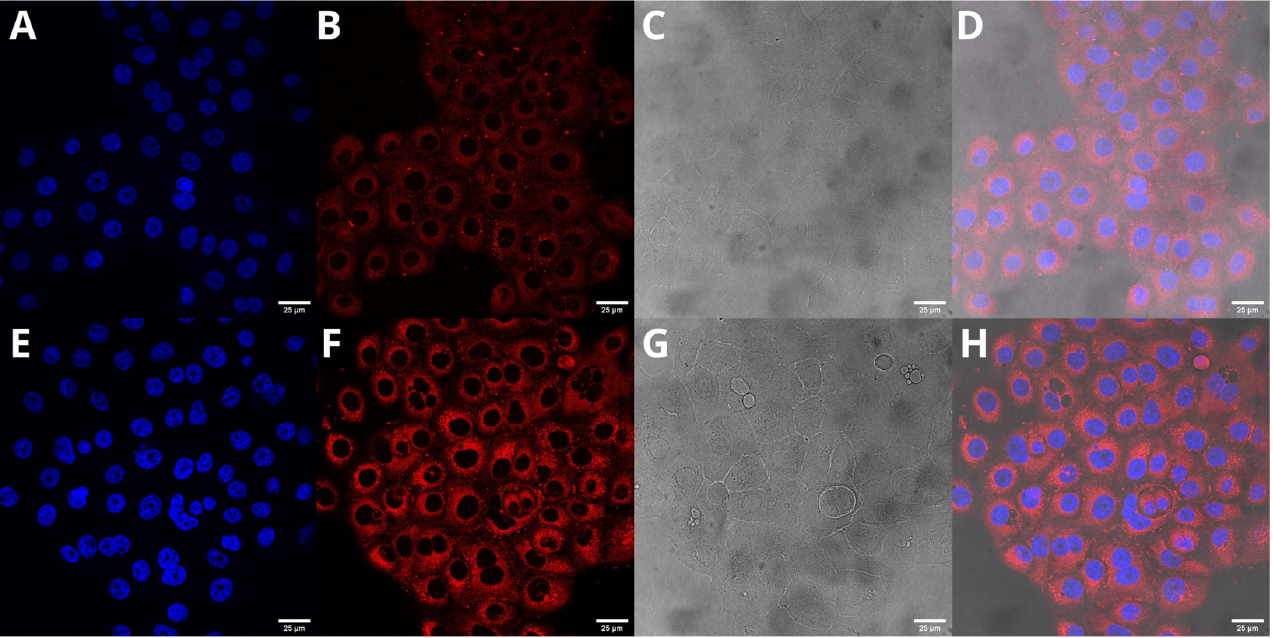
Figure 15. Visualization of the cellular uptake of Nile-Red-loaded UA-S85-PLGA-PEG2000 nanoparticles by BxPC-3 pancreatic cell lines ( A , E ). DAPI ( B , F ). Nile Red fluorescence signal ( C , G ). Transmitted light ( D , H ). The merged image of the cells was observed after 15 ( A – D ) and 120 min ( E – H ) of incubation with the labeled particles. Scale bar = 25 µ